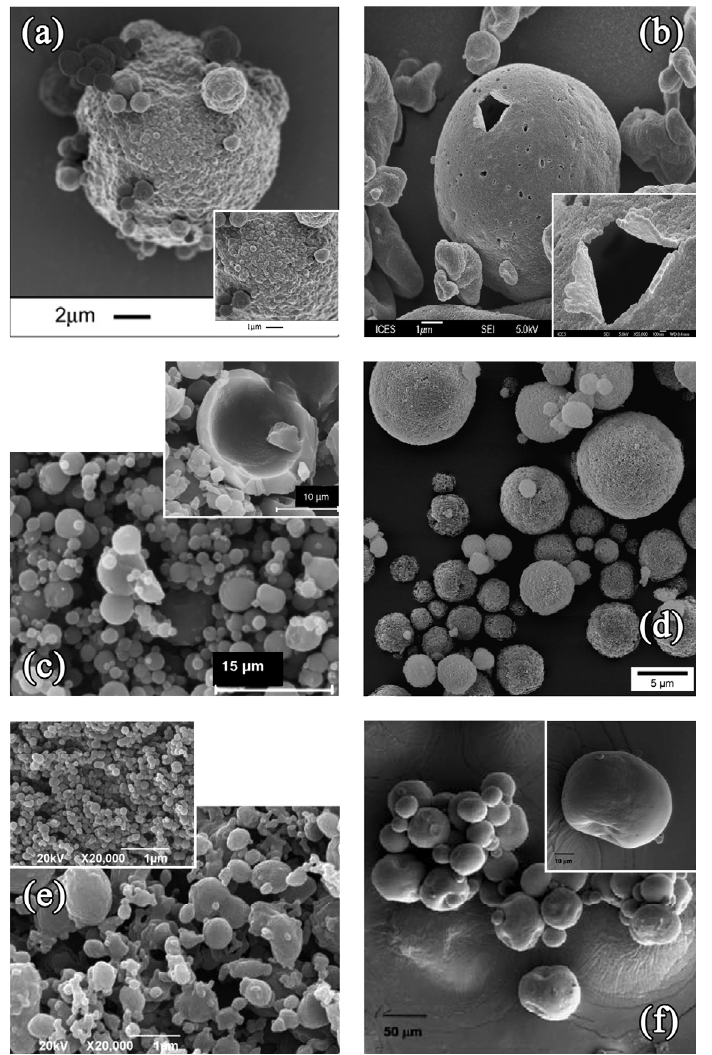
Figure 3. SEM pictures of a representative panel of Trojan microparticles reported